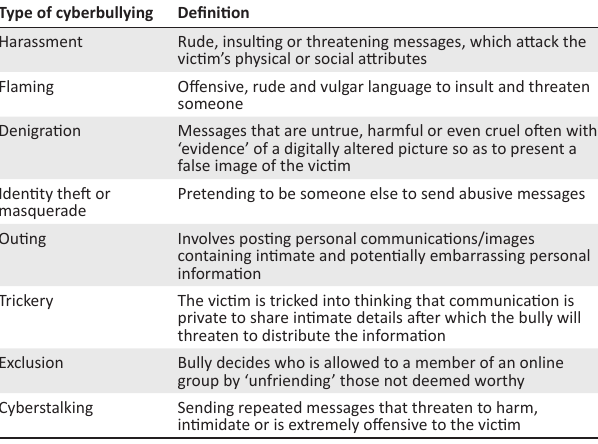
TABLE 1: Types of